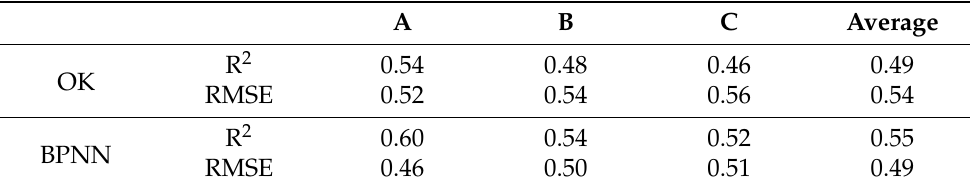
Table 6. Averaged coefficients of determination and root mean square errors of the validation datasets obtained with the two methods.